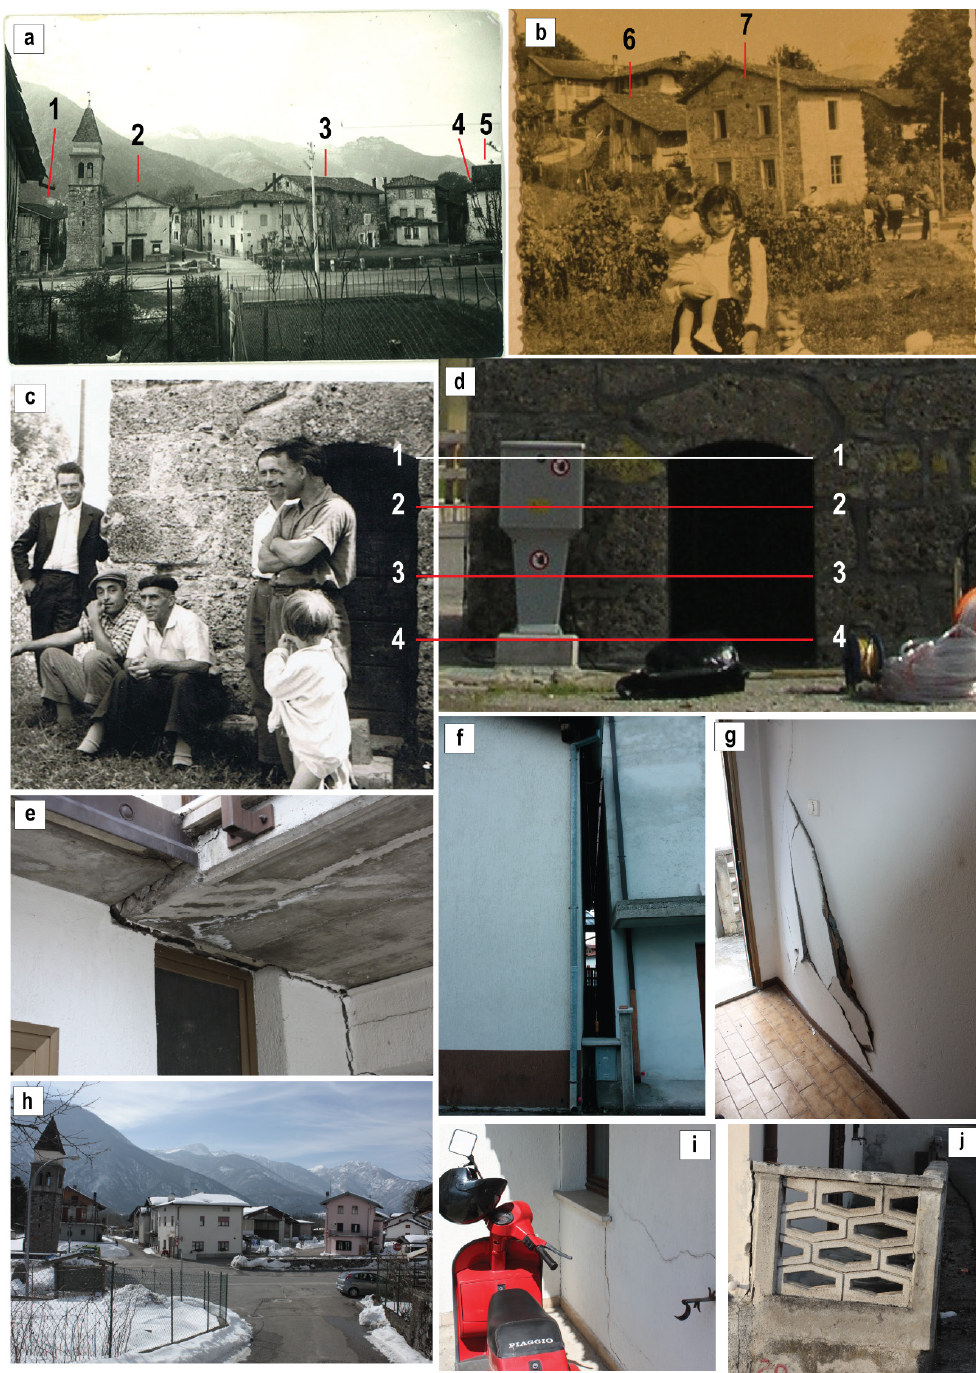
Figure 11. ( a , b ) Photos dated back to 1954, witnessing that the subsiding phenomena heavily affected the area in the past and their evolution has led to the demolition of some buildings; ( c , d ) the bell tower pictured in the sixties and nowadays, respectively. White lines join the same points on the two pictures, the red line highlights the subsidence of the structure; ( e , f , i ) report the fractures present on the walls and at the junction with another house noted as number 9 in Figure 10; picture f shows the convergence between two adjacent buildings; ( g,j ) damages on the internal wall of the house noted as 11 in Figure 10 and the external concrete fence is shown to be detached from the corner; ( h ) panoramic view where the bending of the bell tower and the white house is